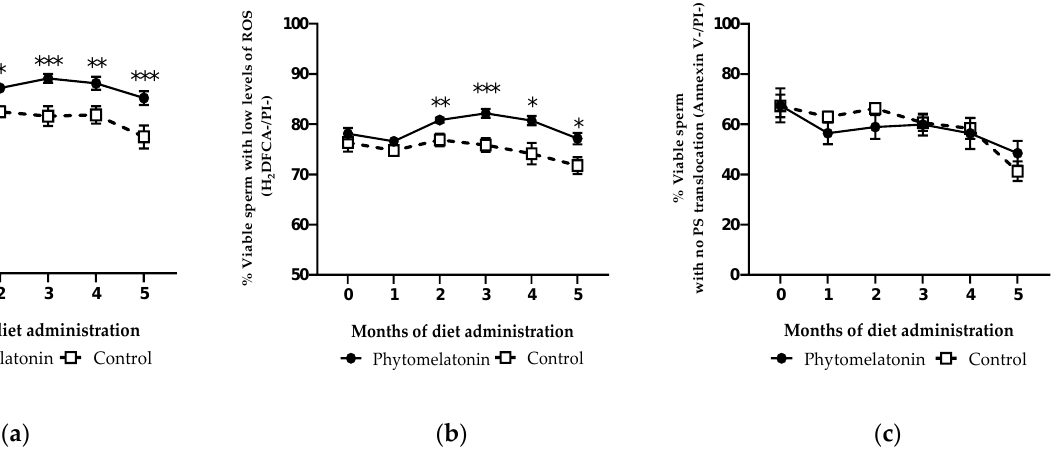
Figure 5. Percentage of viable ( a ), viable with low ROS levels ( b ) and viable without phosphatidylserine (PS) translocation ( c ) spermatozoa in samples from animals fed with a phytomelatonin-rich (●) or commercial (control, □) diet from month 0 (before diet administration) to month 5. Values are shown as mean ± S.E.M., n = 16. * p < 0.05, ** p < 0.01 and *** p < 0.01 indicate significant differences between the two experimental groups.